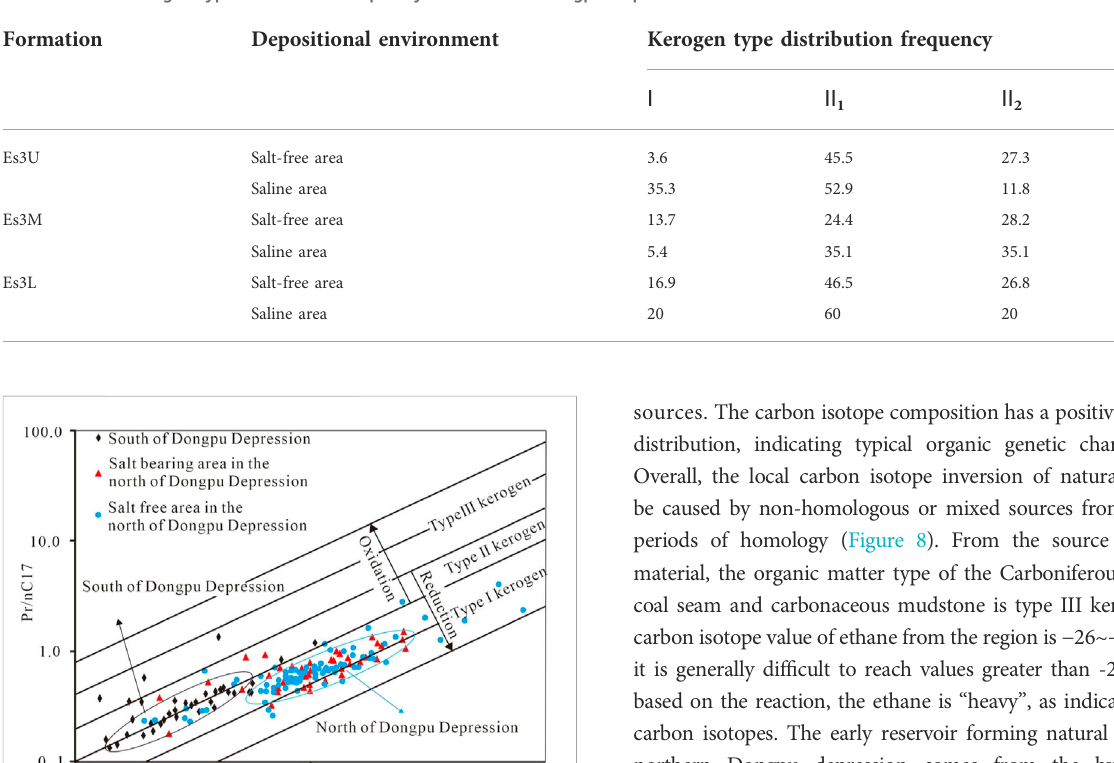
TABLE 2 Shale kerogen type distribution frequency of Es3 in the Dongpu Depression.